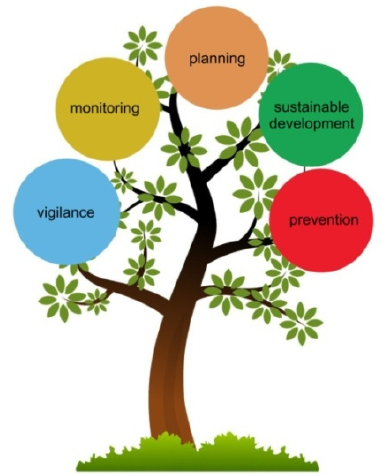
Figure 1. Key issues for Arpae, Italy.